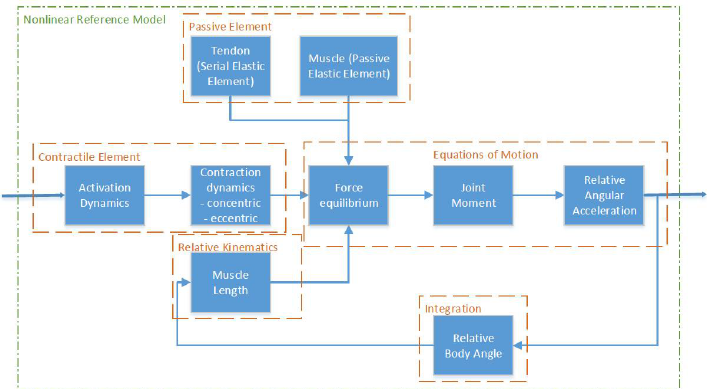
Figure 2. Subsystems and interactions between parts of nonlinear reference model based on Hill-type muscle